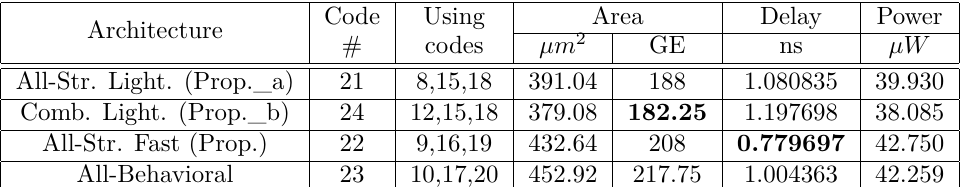
Table 9: ASIC synthesis results for the proposed S-box